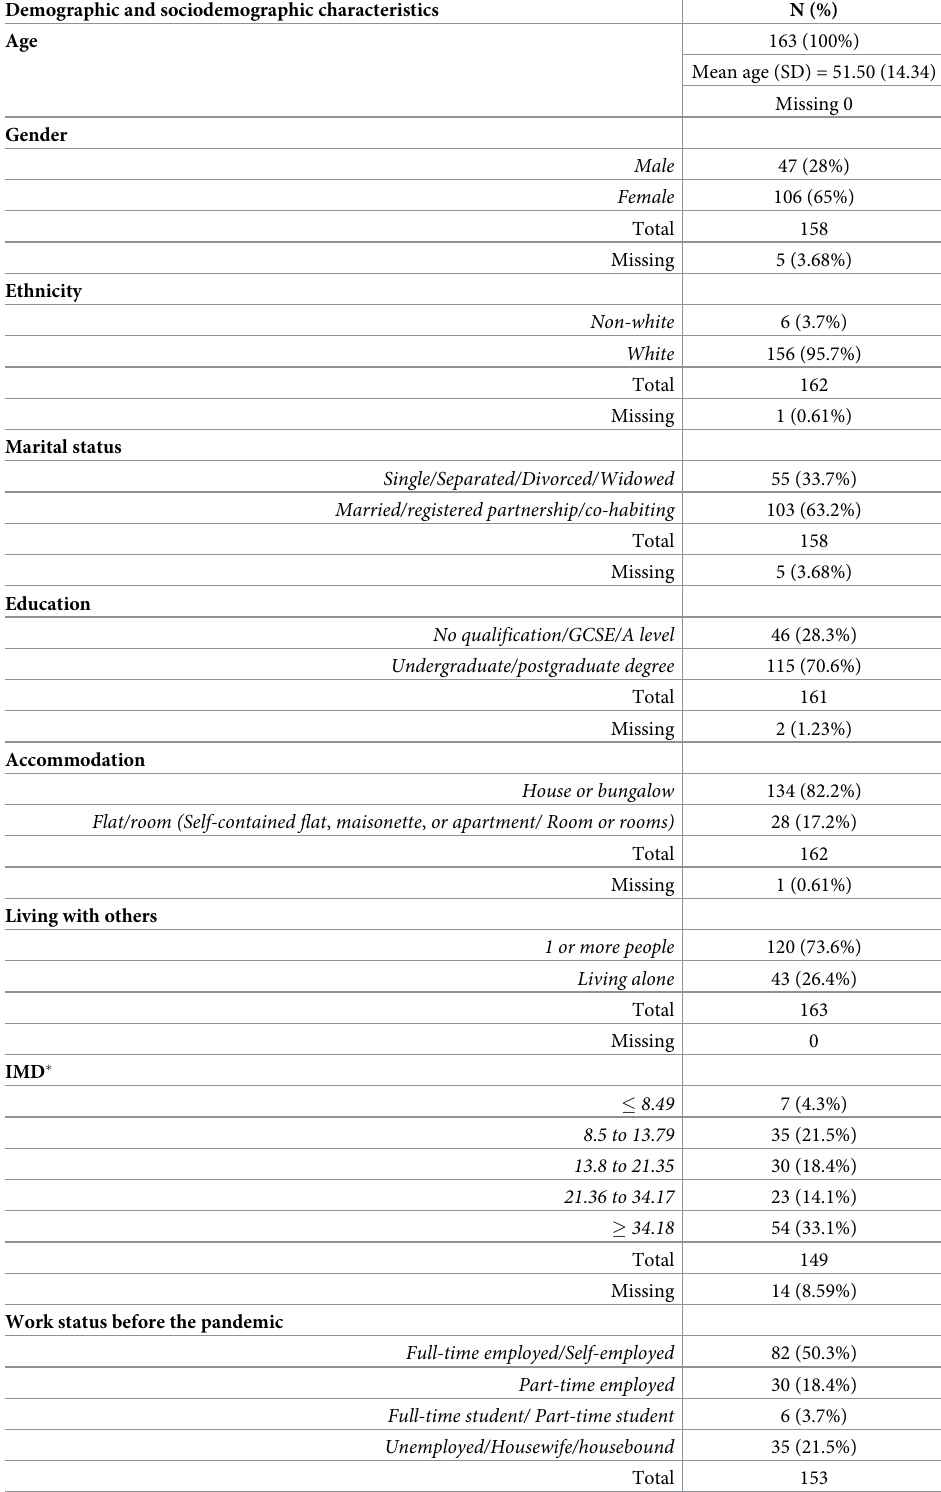
Table 1. Participant demographic and sociodemographic